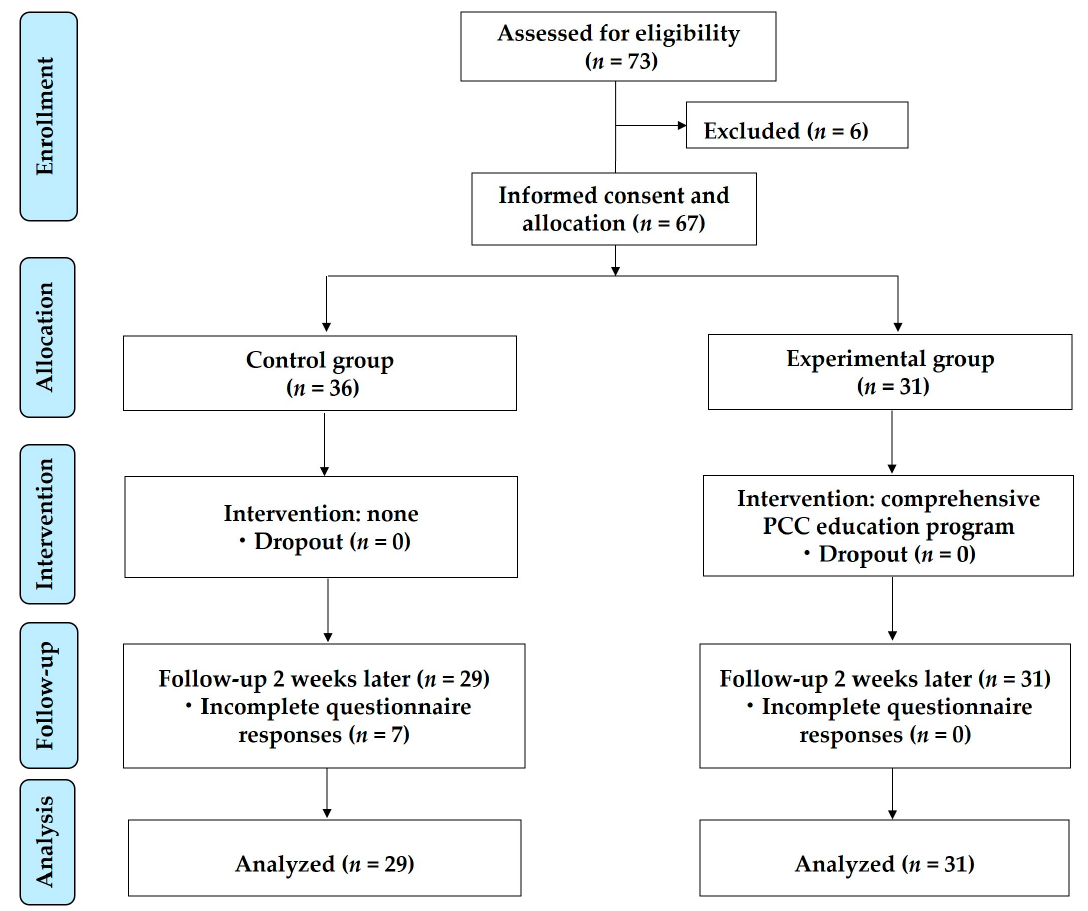
Figure 1. Research flow diagram.